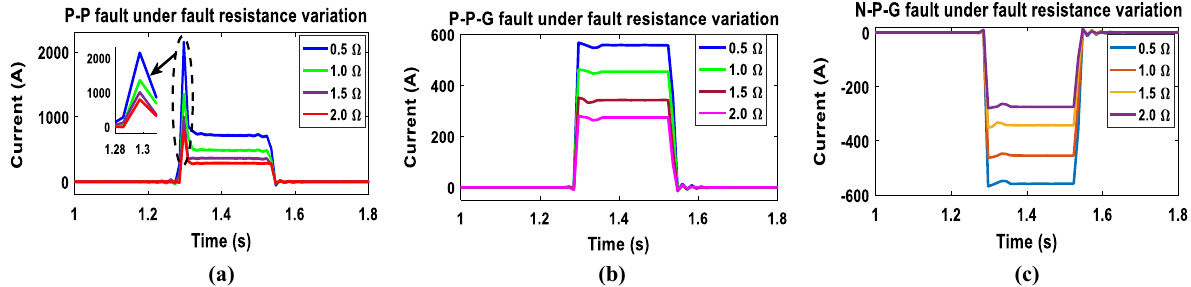
Fig. 6 DC cable faults under faultresistance variation a P-P fault, b P-P-G fault, and c N-P-G fault